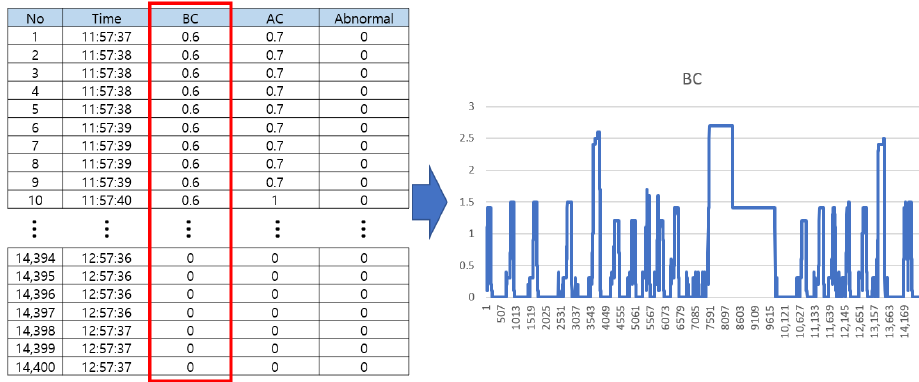
Figure 3. BOU dataset and the extraction of BC pressure